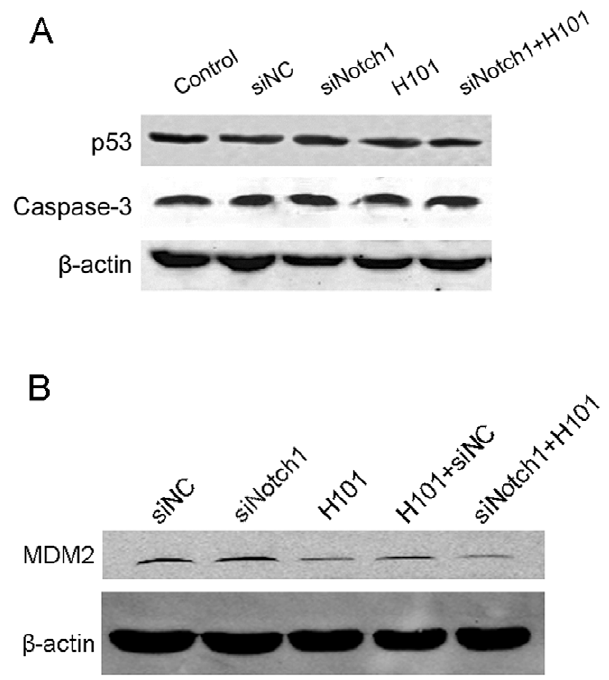
Figure 4. Apoptosis analysis of HeLa-S3 tumor cell induced by the H101- Notch1-siRNA treatment. HeLa-S3 cell was harvested 72 h after transfection, and Annexin V staining was used to analyze early-stage cell apoptosis.